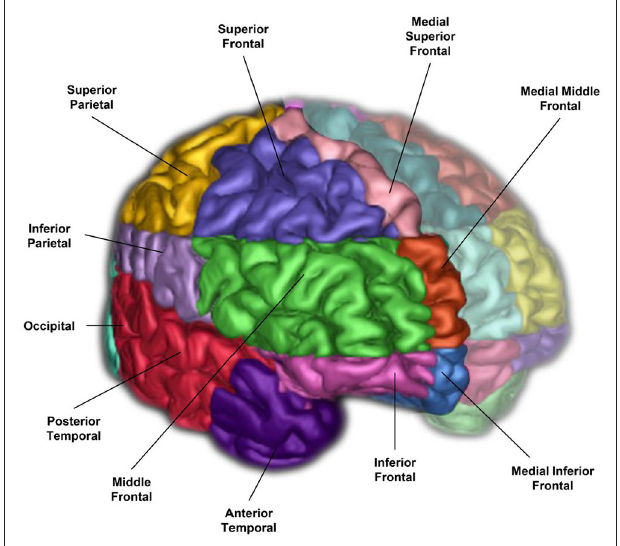
FIGURE 2 | A 3-D surface volume rendering of T1-weighted MRI showing right hemisphere SABRE regions in different colours. Left hemisphere regions were made translucent for illustrative purposes, however, SABRE regions are separately parcellated for each hemisphere and delineated using individualized anatomical landmarks for both left and right